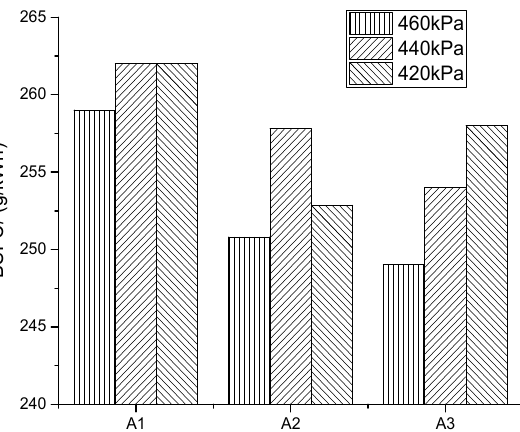
Figure 5. Comparison of BSFC under three inlet pressures for different combustion chambers.